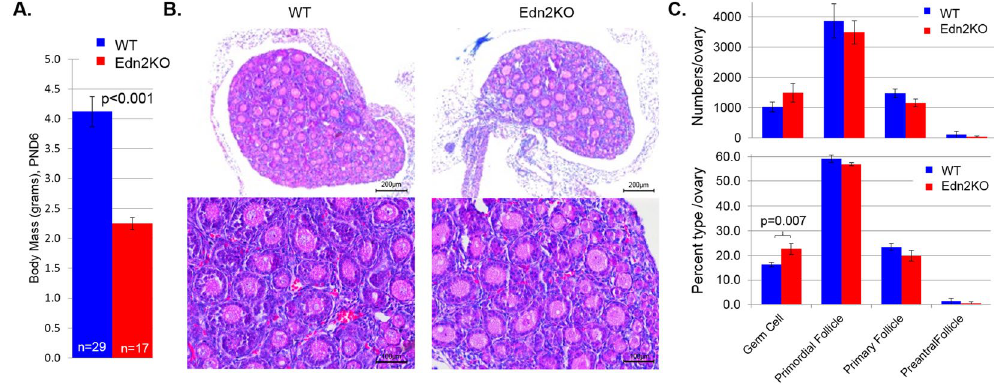
Figure 1. Edn2KO PND6 pups are smaller but have normal ovarian development. ( A ) Average body mass at post-natal day 6 (PND6) of WT (4.12 ± 0.25 g) vs Edn2KO (2.25 ± 0.10 g) pups. ( B ) Representative PND6 WT and Edn2KO ovaries sectioned at 5 μ M. Histology images are shown at 10X and 20X. Both ovaries have a mix of germ cells, primordial follicles, primary follicles, and several preantral follicles. ( C ) Follicle and germ cell counting was performed on PND6 WT and Edn2KO and control ovaries (n = 10). Absolute cell counts are displayed above and the percentage of total cells per ovary is displayed below. A significant difference was seen between the percentage of germ cells present (p = 0.007). No other significant differences were noted. Error bars display the